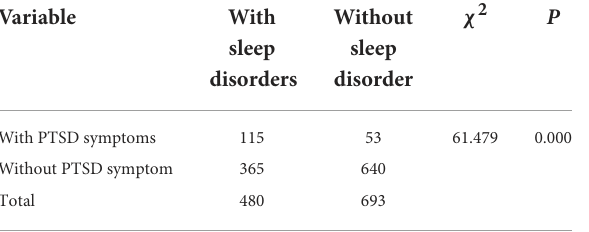
TABLE 4 Comparison of the incidence of sleep disorders between elderly adults with and without PTSD ( n %). Variable